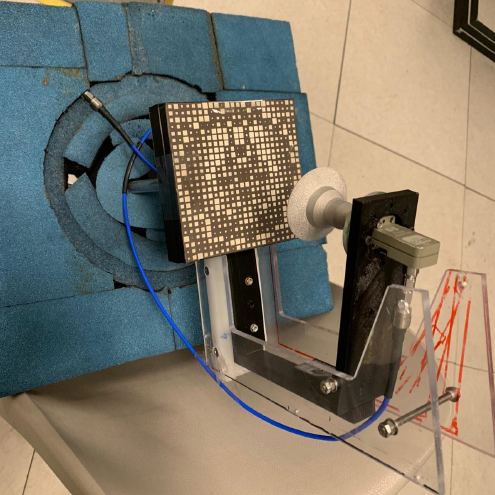
Figure 15. Prototype of the RA with the support structure.